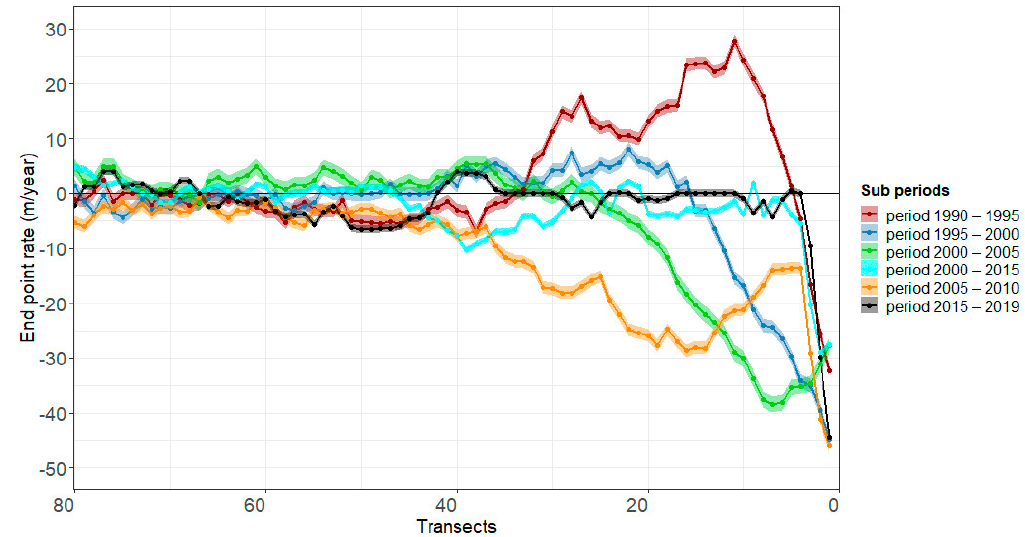
Figure 16. Temporal variation of north Cua Dai over six sub-periods, with Transect 0 starting from Cua Dai estuary (with the shadow of each line indicates the standard deviation error).